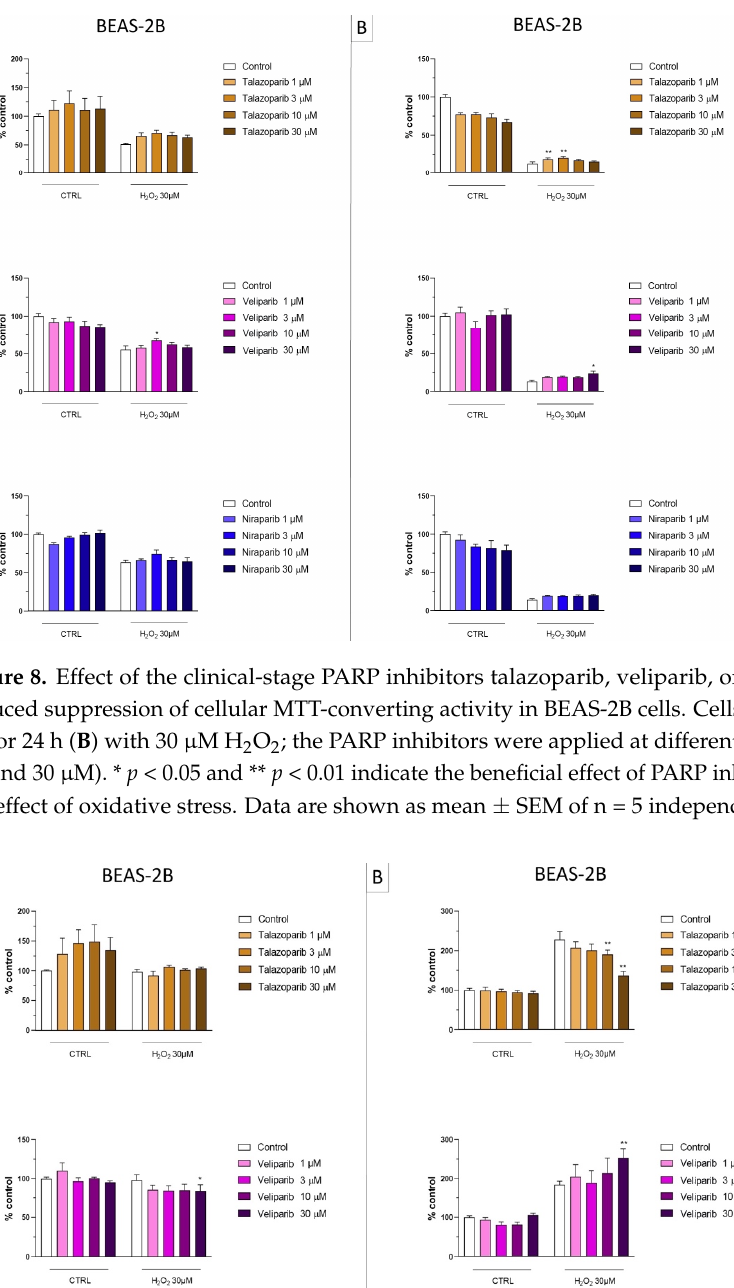
Figure 7. Effect of the clinical-stage PARP inhibitors olaparib or rucaparib on H 2 O 2 -induced cell necrosis in BEAS-2B cells. Cells were treated for 2 h ( A ) or 24 h ( B ) with 30 µM H 2 O 2 ; the PARP inhibitors were applied at different concentrations (1, 3, 10, and 30 µM). Cell necrosis was measured by measurement of LDH levels in the supernatant. * p < 0.05 and ** p < 0.01 indicate the beneficial effect of PARP inhibition to counteract the effect of oxidative stress. Data are shown as mean ± SEM of n = 5 independent experiments.